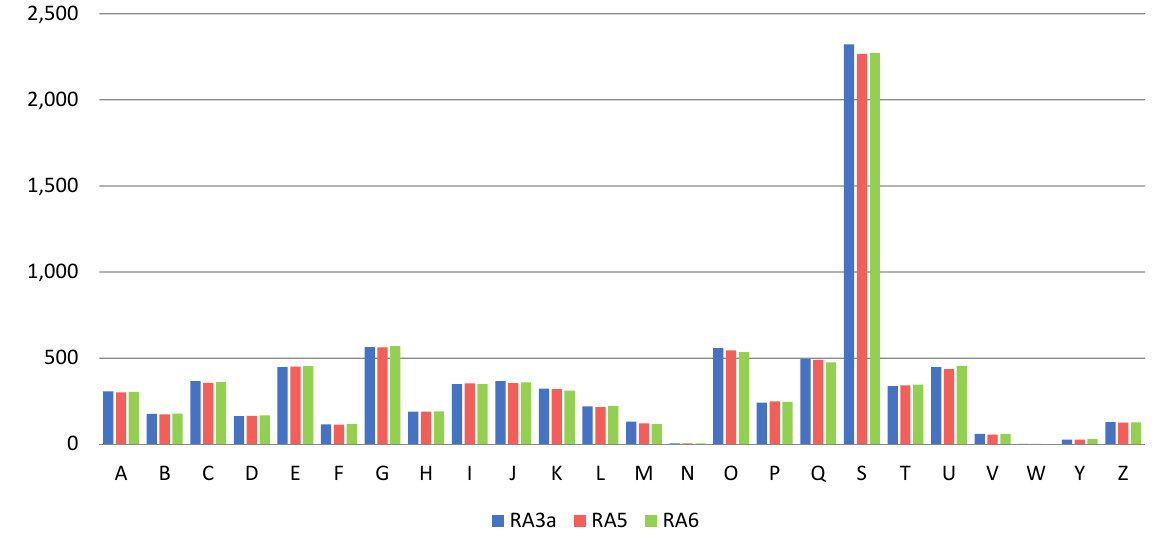
Figure 4. Distribution of predicted proteins in the three fungal isolates RA3a, RA5, and RA6 across